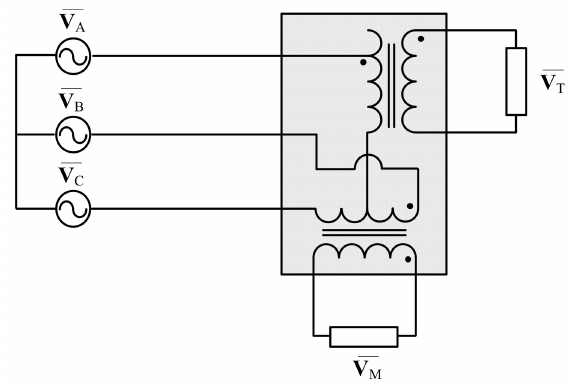
Figure 1. The basic structure of Scott transformer.